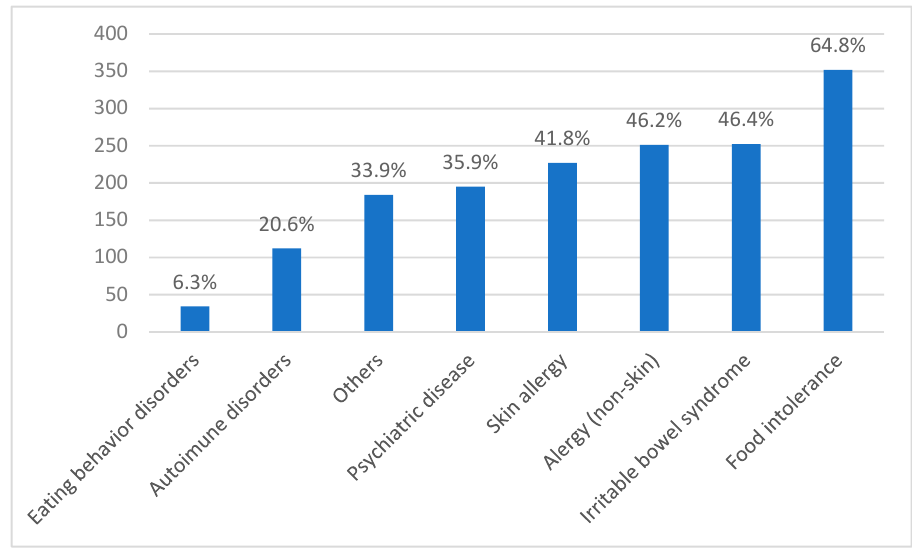
Figure 4. Disorders associated with Brazilian suspected non-celiac gluten sensitivity (N = 543).